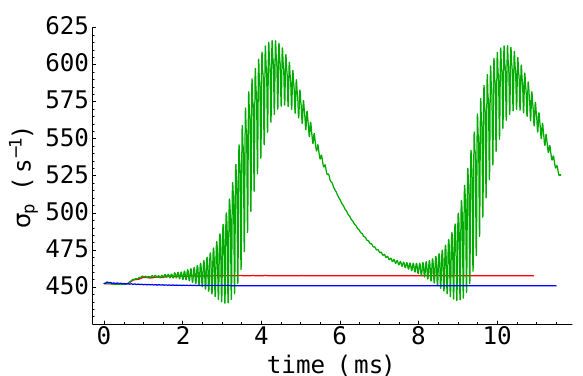
FIG. 18. (Color) Simulated energy spread of three 300 mA fully stretched bunches that differ in the ring impedances in which they propagate. From bottom to top the ring impedances are main-cavity and harmonic-cavity fundamental rf modes only (blue trace), broadband impedance consisting of a Q (cid:1) 1.118 resonator with j Z n (cid:3) n j (cid:1) 1.84 V and resonant frequency 2.0 GHz only (red trace), and broadband impedance and high- Q rf modes combined (green trace). The tunes of the rf modes are re- alistically adjusted for beam-loading compensation. Machine parameters are given in Table I.